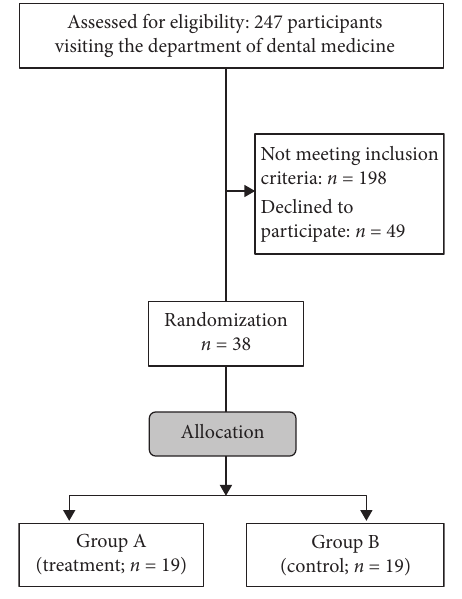
Figure 4: Flowchart of participants included in the study. Table 1: Characteristics of the treatment group ( n � 19) and the control group ( n � 19).